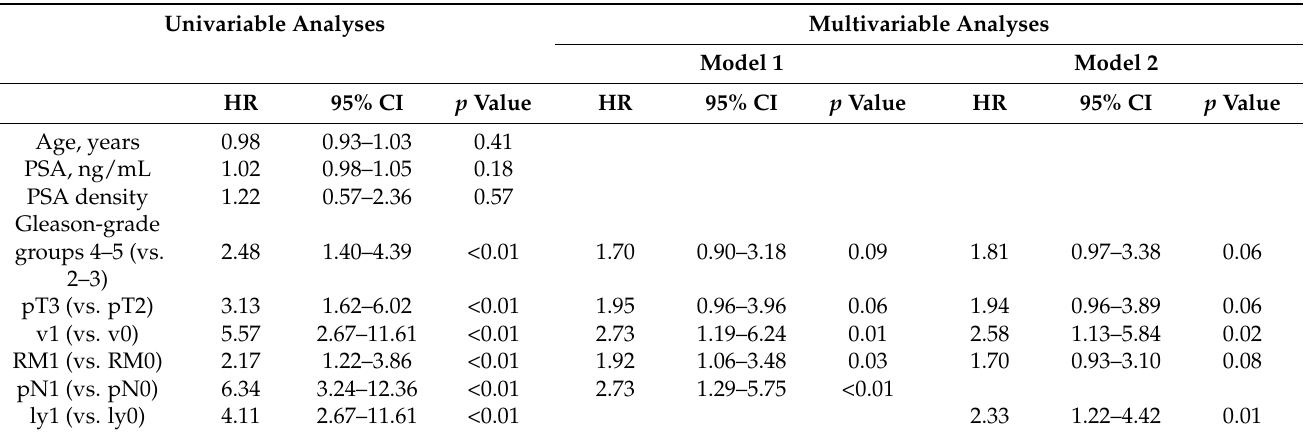
Table 3. Univariable and multivariable analyses of associations between various parameters and BCR in the overall patient group.